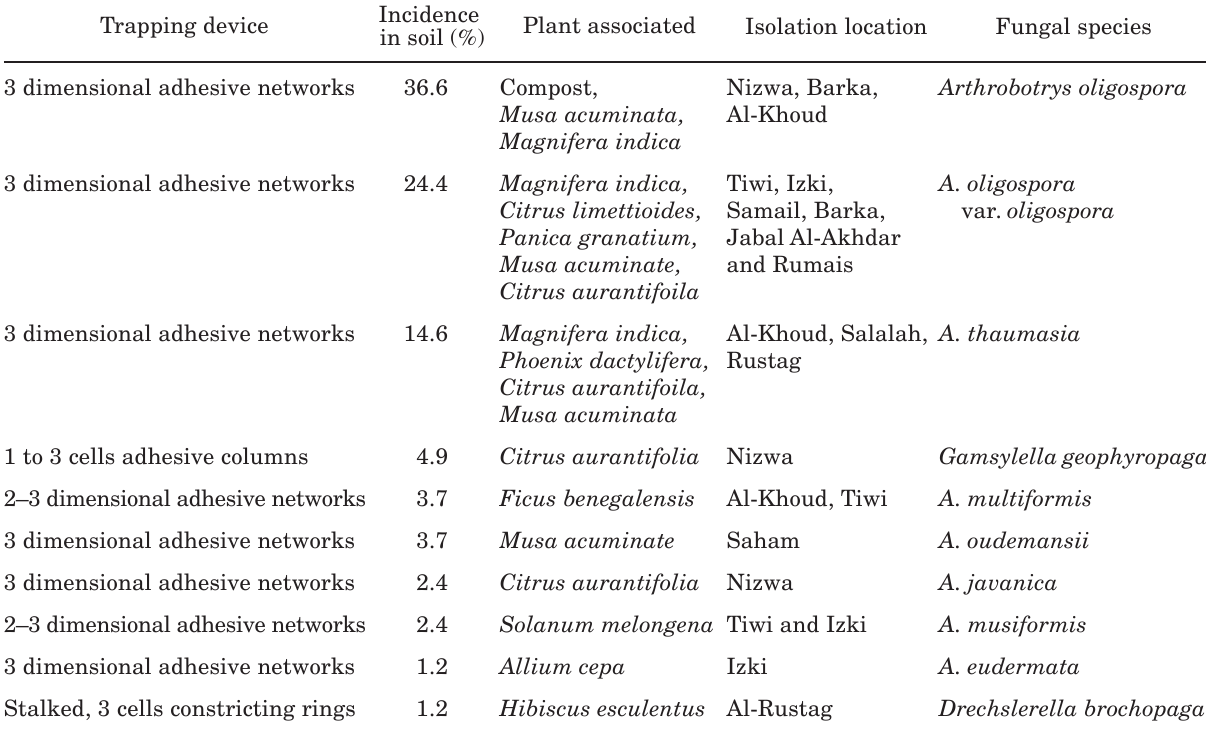
Table 1. Locations, source, incidence and trapping devices of nematophagus fungal species in Oman. Incidence Trapping device Plant associated in soil